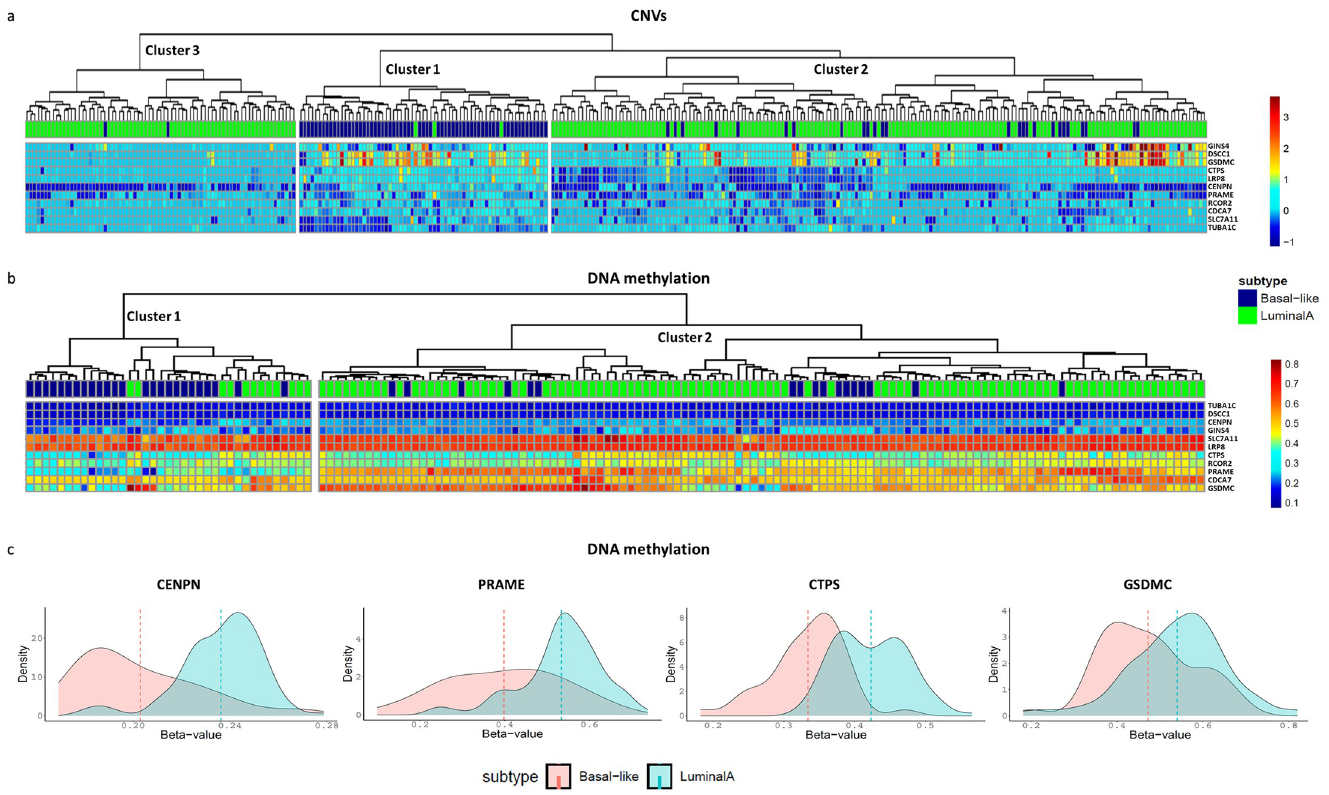
Fig 7. Genomic and epigenomic alterations of the basal-like prognostic biomarkers. a) Heatmap with dendrogram representing the unsupervised hierarchical clustering analysis based on CNVs data of TCGA-BRCA patients. The rows in the heatmap represent the 11 basal-like prognostic biomarkers. The columns correspond to basal-like and luminal A TCGA-BRCA patients: basal-like are indicated in dark blue and luminal A in green. The cells of the heatmap represent the log2 segment mean value of CNVs (ranging from -1 up to 3.5), for which colour code is indicated in the scale on the right-hand side of the figure. b) Heatmap with dendrogram representing the unsupervised hierarchical clustering analysis based on DNA methylation data of TCGA-BRCA patients. The rows in the heatmap represent the 11 basal-like prognostic biomarkers. The columns correspond to basal-like and luminal A TCGA-BRCA patients: basal-like are indicated in dark blue and luminal A in green. The cells of the heatmap represent beta-value (ranging from 0 to 1) extracted from Illumina 450k normalized data, for which colour code is indicated in the scale on the right-hand side of the figure. c) Distribution plot of beta-value of CENPN, GSDMC, PRAME and CTPS genes in basal-like and luminal A patients. Dashed lines represent the mean of beta-values for each patients’